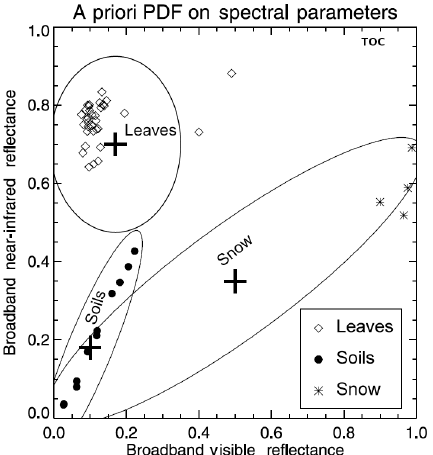
Table 1. Mean values x 0 and associated standard deviations σ( x 0 ) used to set the diagonal of the prior uncertainty covariance matrix C ( x 0 ) . (cid:49) λ and (cid:49) λ correspond to the broadband visible 1 2